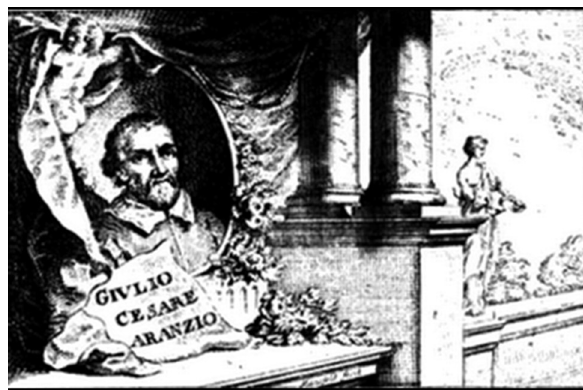
Figure 1. Giulio Cesare Aranzio, from Bologna (illustration from Bram- billa, 1781).